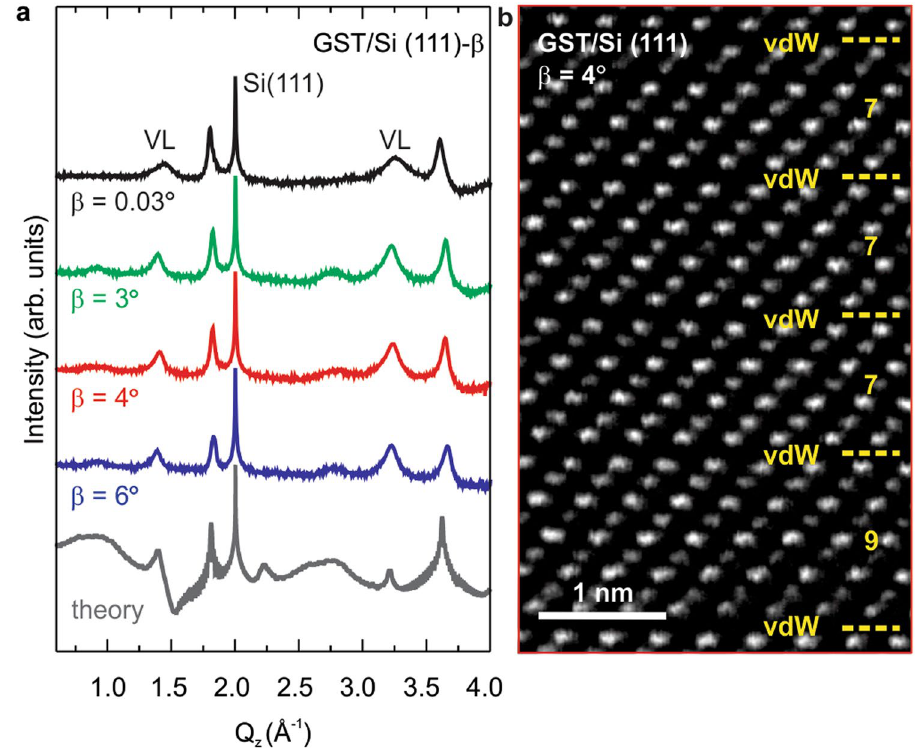
Figure 1. The vicinal surfaces allows for high crystalline quality chalcogenides with reduced structural disorder. ( a ) X-ray diffraction (XRD) ω -2 ϑ scans for crystalline GeSbTe (GST) grown on Si (111) with a miscut orientation ( β ) of 0.03° (black), 3° (green), 4° (red), 6° (blue). The substrate miscut improves the FWHM of the vacancy layer (VL) peaks. The gray curve is the simulation of GST grown on miscut. ( b ) Cross-view [11–20] high resolution HAADF-STEM micrograph of epitaxial GST (00.1) on Si (111) with β = 4°. Van der Waals (vdW) gaps (dashed yellow lines) occur every 7–9 atomic